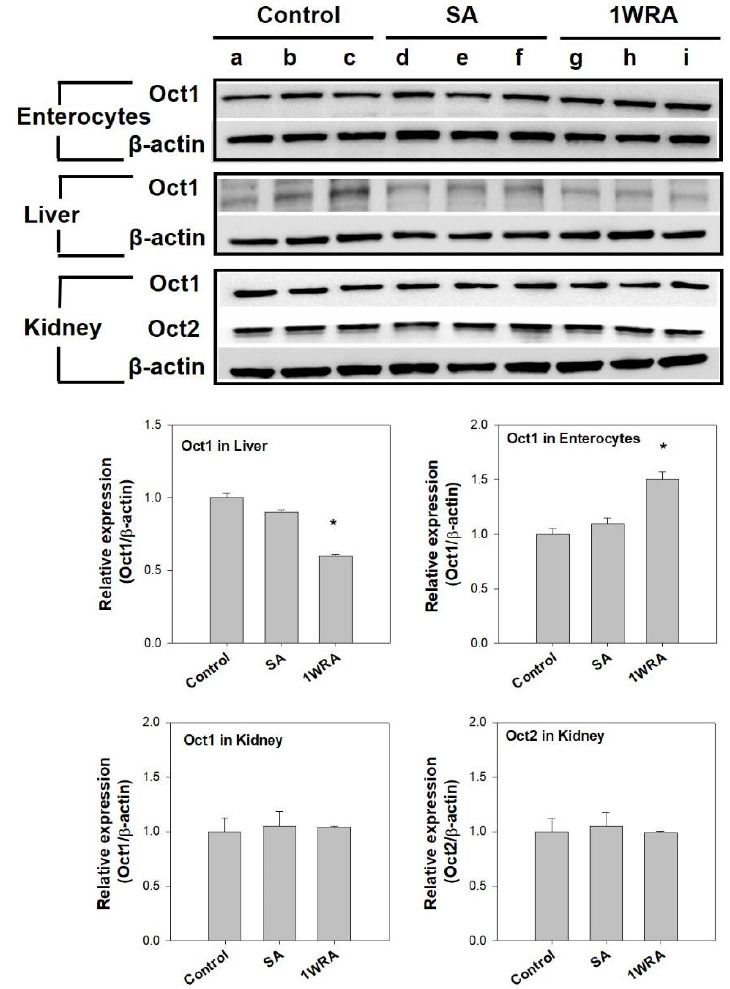
Figure 3. Protein expression of organic cation transporter 1 (Oct1) in the ileal enterocytes, liver, and kidney and Oct2 in the kidney of rats in control (lanes a, b, and c), single RGE treatment (SA, lanes d, e, and f), and 1-week repeated RGE administration (1WRA, lanes g, h, and i) groups and β -actin was used as a loading control. Quantitative analysis of western blot results is shown in the lower panel. Bars are mean ± SD of three independent densitometric analyses; * p < 0.05 compared with control group (by Student’s t -test).